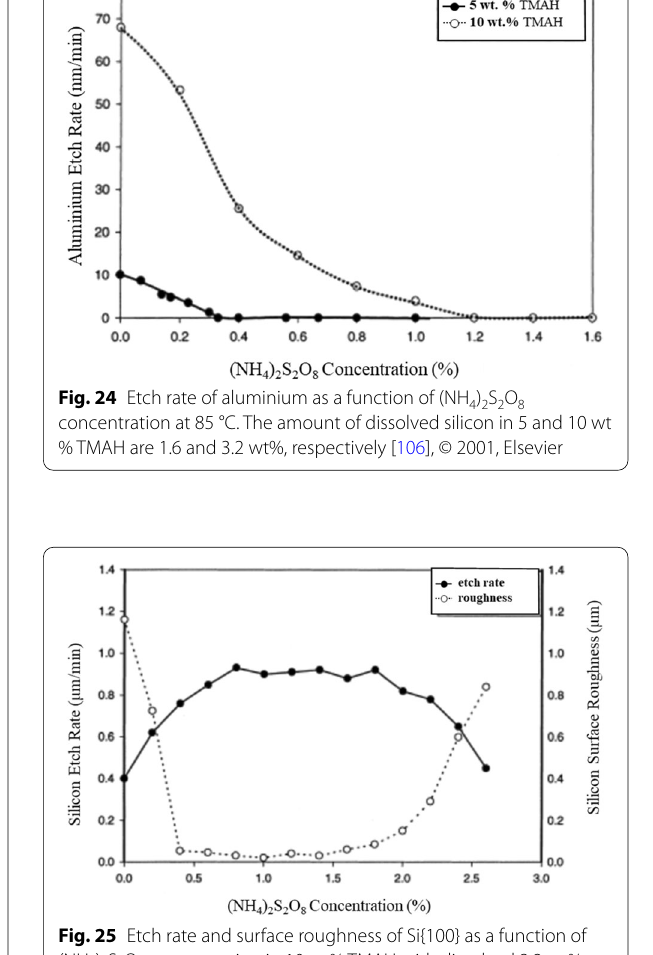
Fig. 23 Average etching rate of Si{100} in pure and surfactant-added a 30 wt% KOH and b 10 wt% TMAH at different etching temperatures [56], © 2005, Elsevier